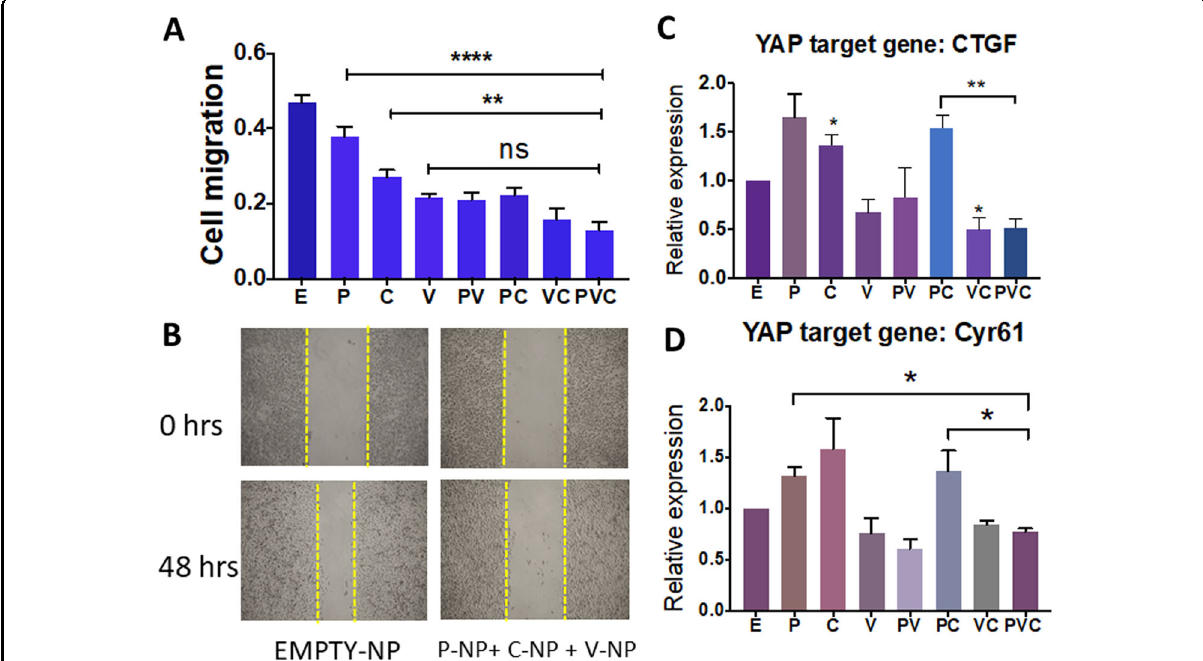
Fig. 2 Vertepor fi n-NP more effectively inhibits the migration of TNBC cells and fully suppresses YAP target genes upregulated by paclitaxel-NP and/or combretastatin-NP. A TNBC MDA-MB-231 cells were grown to con fl uence, treated with mitomycin to inhibit cell proliferation, and then scratched and quanti fi ed for migration after incubation with E (empty-NP), 5 nM P (paclitaxel-NP), 250 nM V (vertepor fi n-NP), 5 nM C (combretastatin-NP), or different combinations for 48 hrs. B Representative images of A. C , D RT-qPCR analysis of changes of YAP target gene in MDA-MB-231 cells after 24 -hr of treatment with E (empty-NP), 25 nM P (paclitaxel-NP), 1.25 µM V (vertepor fi n-NP), 25 nM C (combretastatin-NP), and different combinations. Data represent means ± SEM, * P < 0.05, ** P < 0.01, **** P <